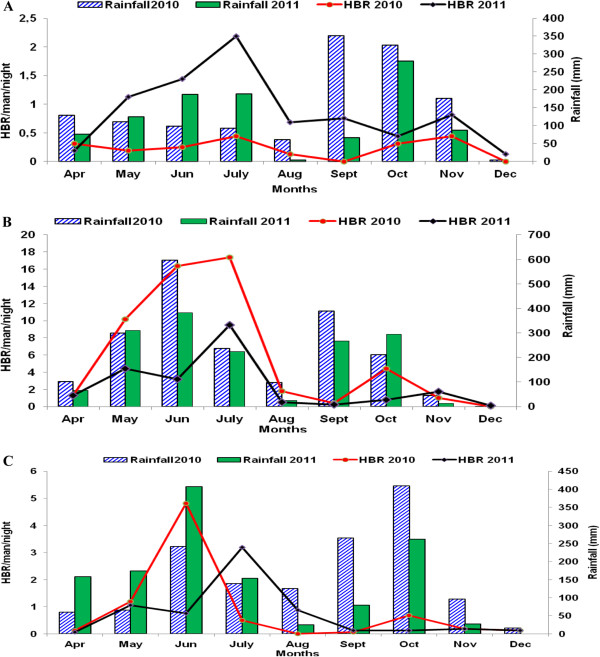
Aggressive variation of An. gambiae s.l density depending on rainfall in Adjohoun (A), Sèmè (B) and Dangbo (C).